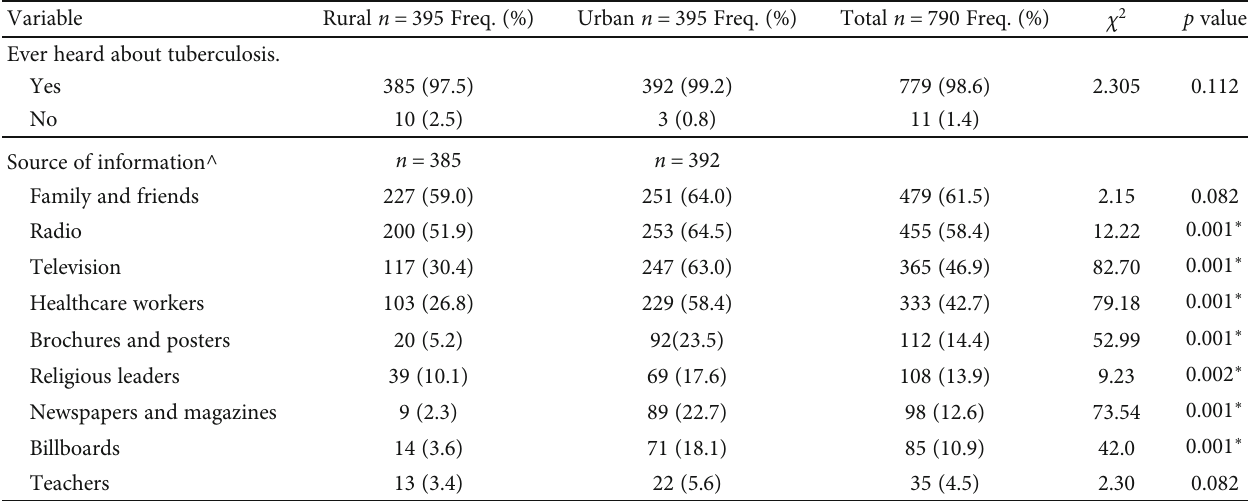
Table 2: Awareness of tuberculosis and source of information about TB.